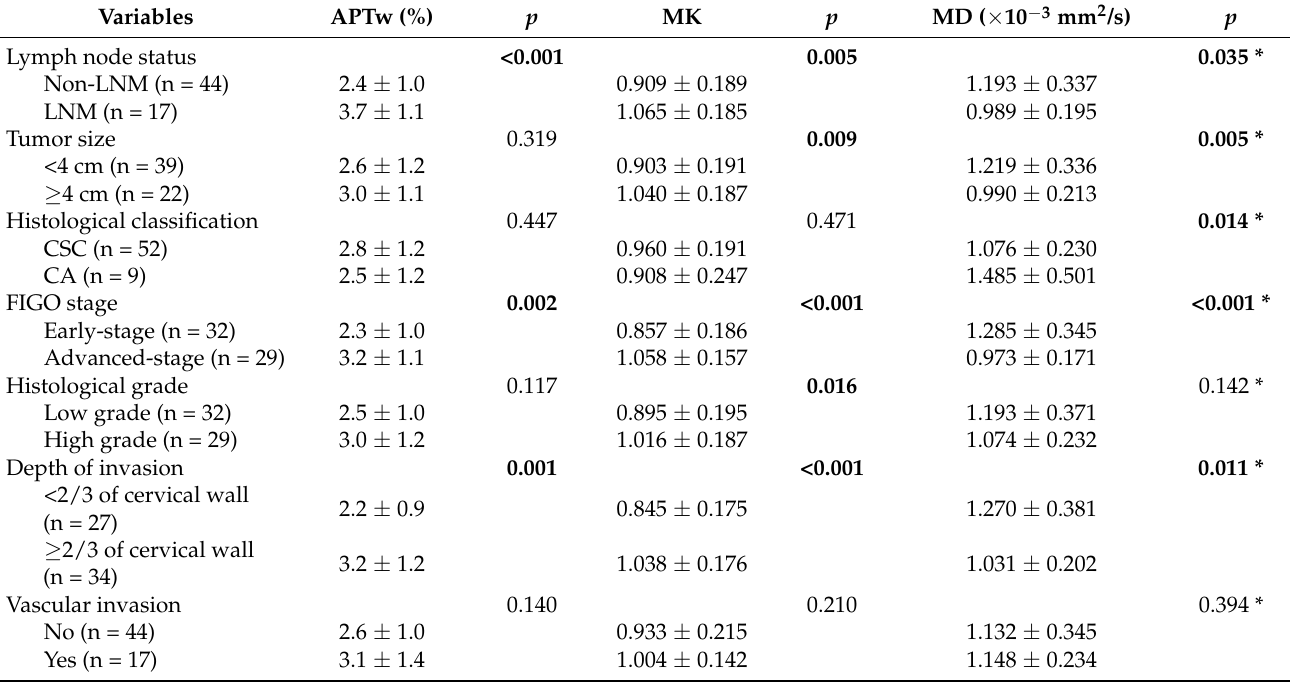
Table 2. Comparison of APTw and DKI-derived parameters among different histopathological parameters of cervical cancer.